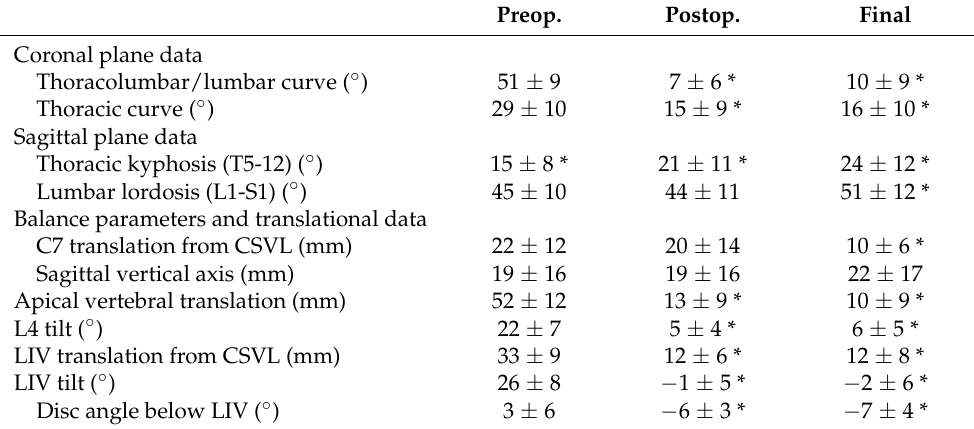
Table 2. Radiographic parameters for all 62 cases.